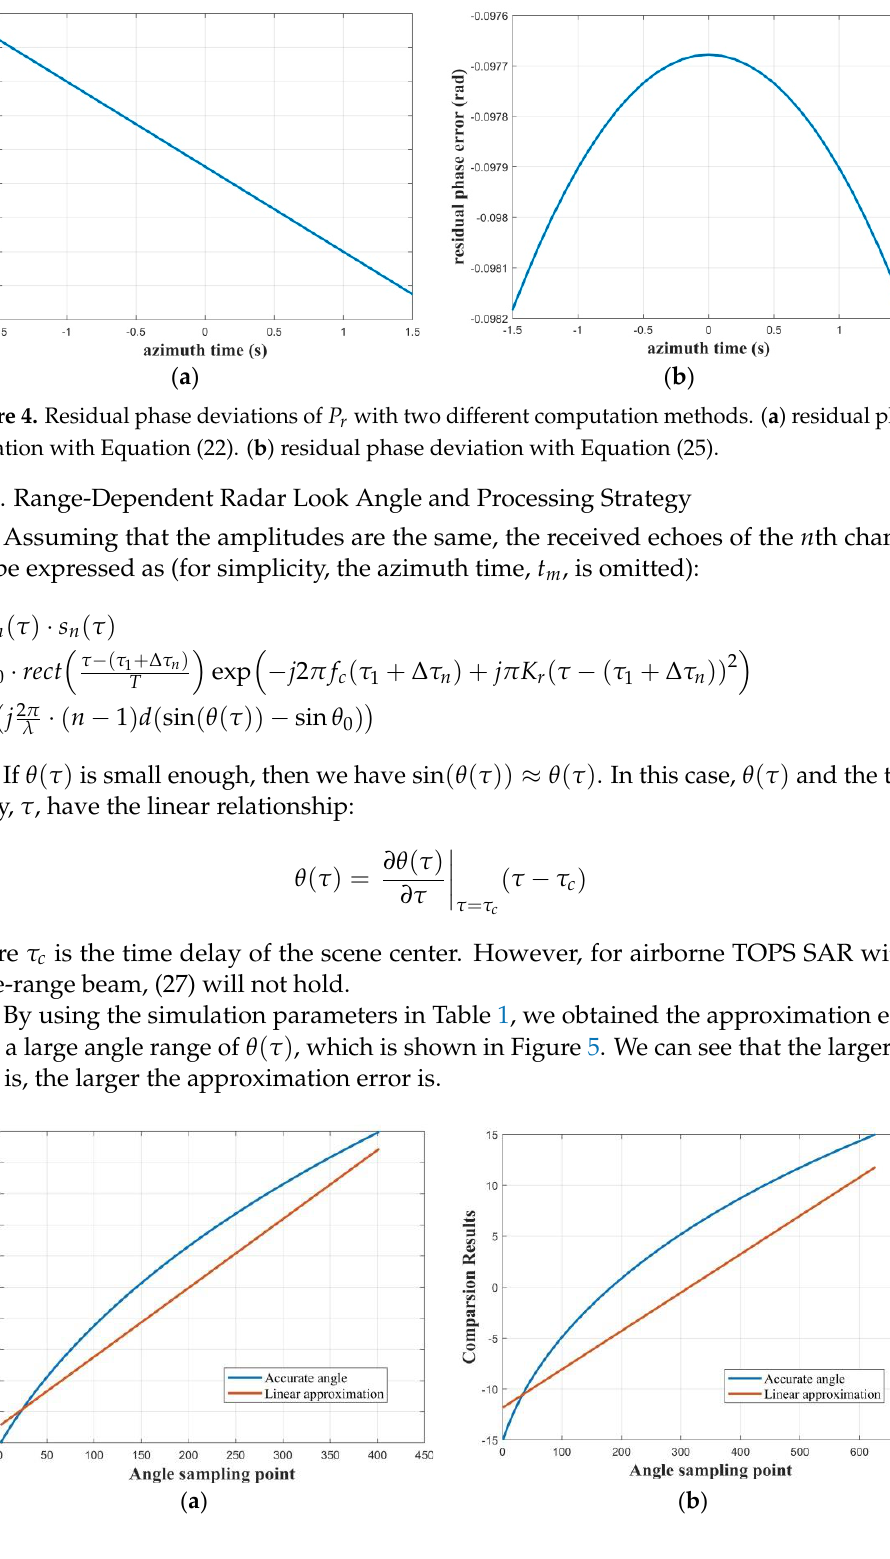
Figure 5. Linear approximation error with a large angle range of θ ( τ ) . ( a ) θ ( τ ) ∈ [ − 10 ◦ , 10 ◦ ] . ( b ) θ ( τ ) ∈ [ − 15 ◦ , 15 ◦ ]